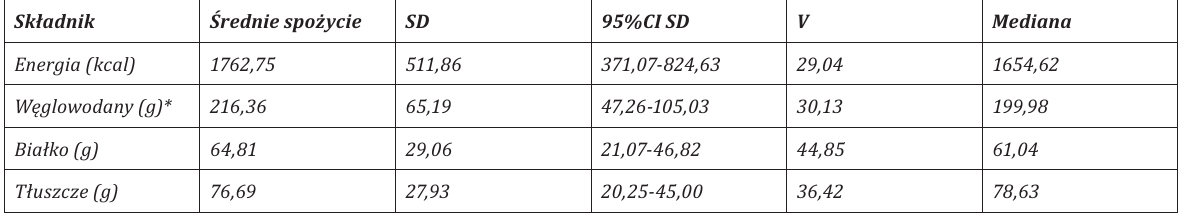
Tabela 3. Wartość energetyczna i zawartość makroskładników w dietach badanych kobiet